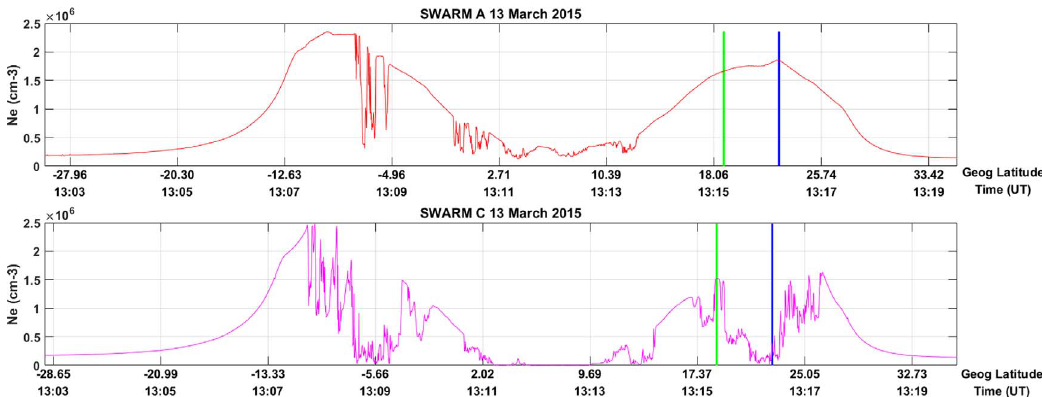
Fig. 4. Variations of electron density with latitude along the longitude of about 101 (top pane) and 104 (bottom pane) degree on 13 March 2015. The blue and green lines indicate, respectively, the position of PUR and CMU